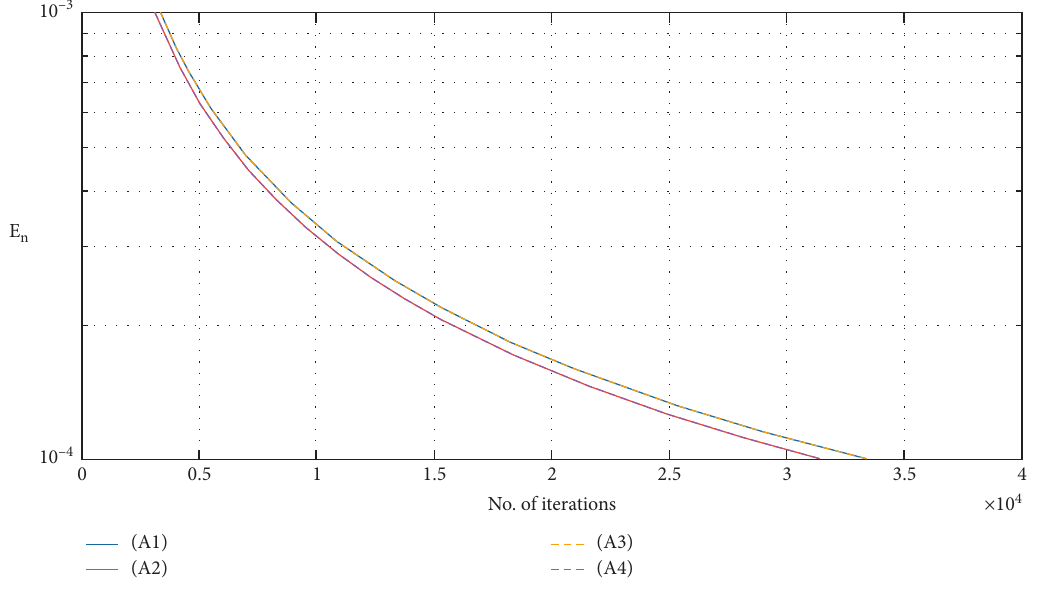
Figure 4: The convergence behavior of E